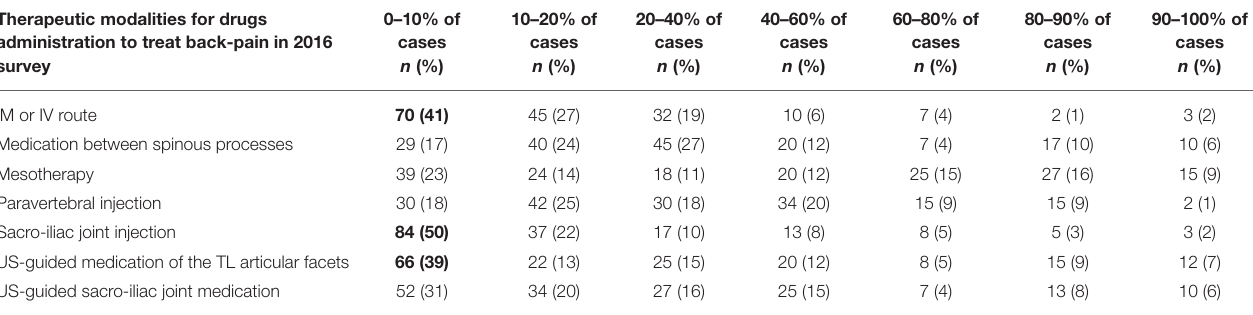
TABLE 6 | Therapeutic routes and corresponding frequencies to treat back disorders in horses by 2016 survey respondents. Therapeutic modalities for drugs administration to treat back-pain in 2016 survey